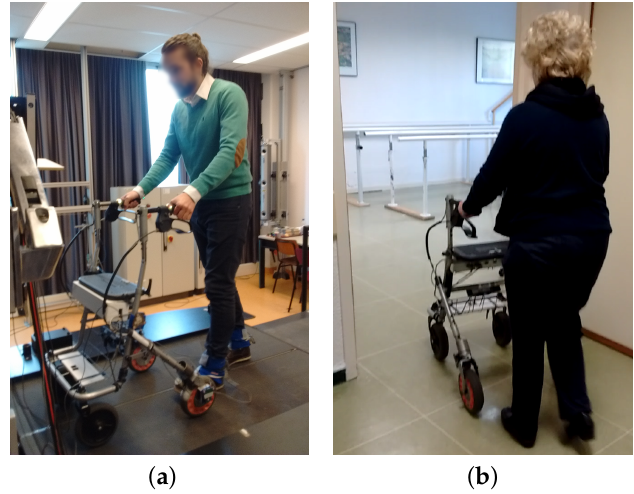
Figure 1. Healthy volunteer over a treadmill with two markers attached in the heel at Vrije Universiteit Amsterdam (VUA) ( a ); Amputee below knee using the i-Walker platform at Hospital Regional Universitario (HRU) ( b